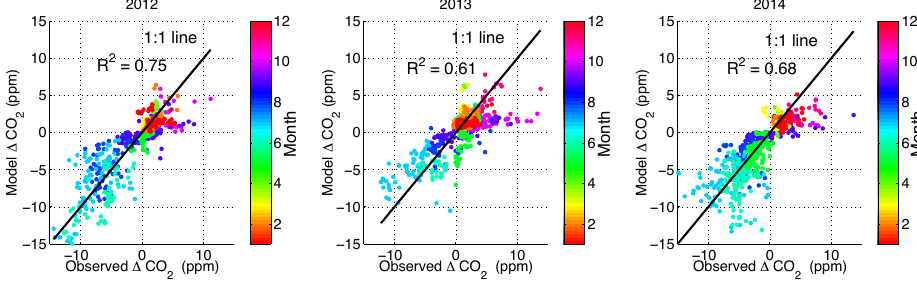
Figure 7. Correlation between observed and modeled (cid:49) CO 2 for 2012 (left), 2013 (center), and 2014 (right), colored by month. The coef- ficient of determination, R 2 , is indicated in each plot, along with the one-to-one line. Data points represent hourly averages between 13:00 and 18:00LST and filtered according to criteria described in the